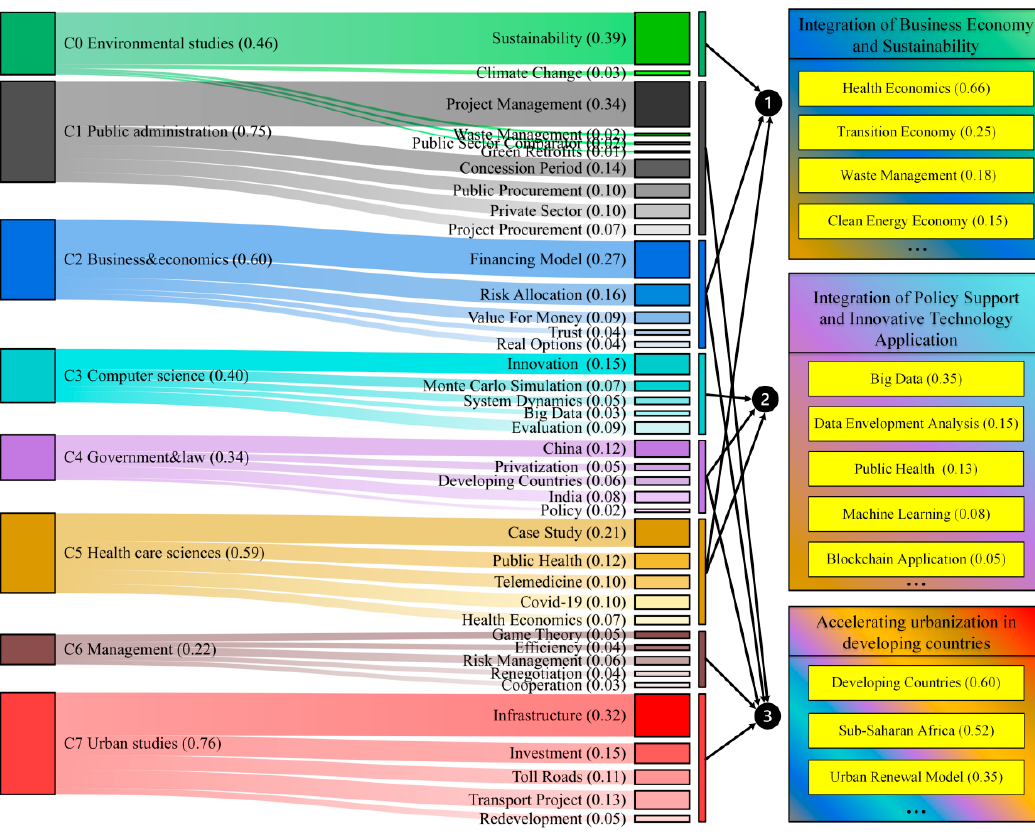
Figure 13. Keyword diversion prediction.